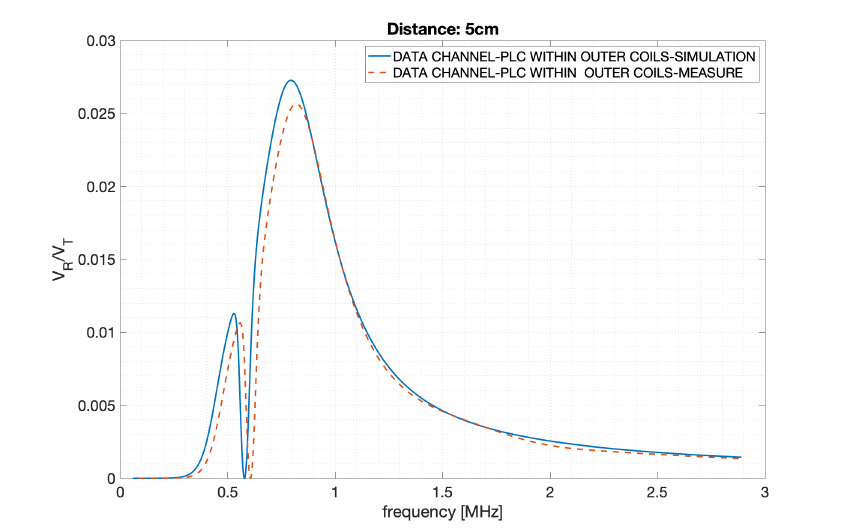
Figure 10. Transfer Functions comparison between measurement and calculations for the data channel, case